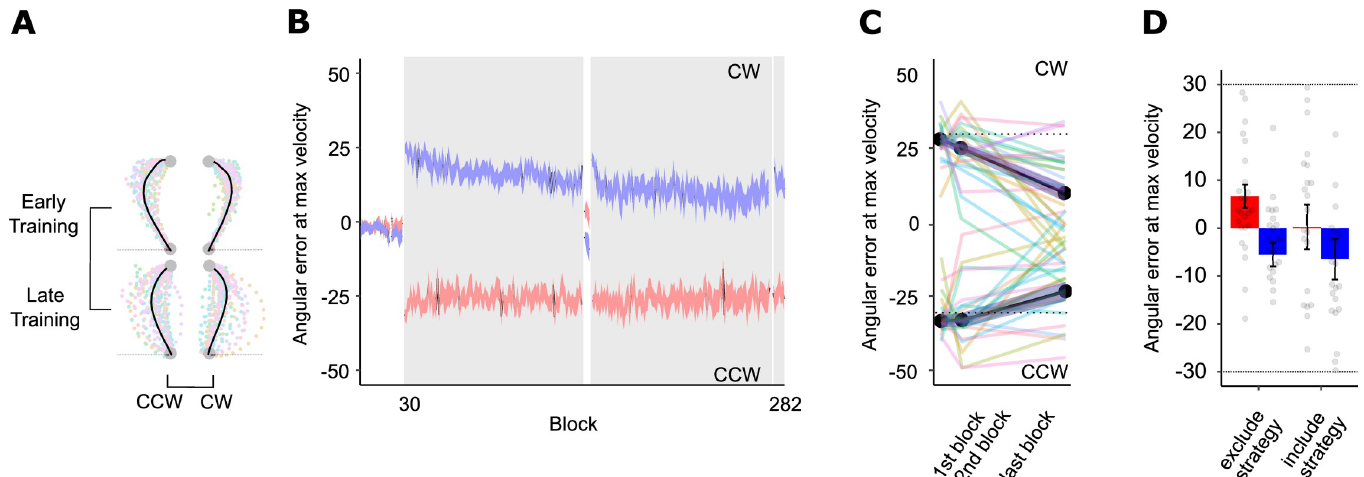
Fig 5. Experiment 1b performance. A. Averaged hand-cursor trajectories for the Active Lead-in group. Colored translucent dots represent individual trajectories. B. Visuomotor adaptation across training blocks. The learning curve for CW trials is in blue, and CCW trials in red. C. Truncated visuomotor adaptation across training for the Active Lead-in group. Colored translucent lines represent individual learning curves. D. Reach aftereffects in post-training. Grey dots represent individual participant errors. Red bars represent CW errors and blue bars represent CCW errors. Dashed lines represent rotation magnitude experienced during training (30˚ CW and 30˚ CCW). Dashed lines represent the rotation magnitude. Error bars represent